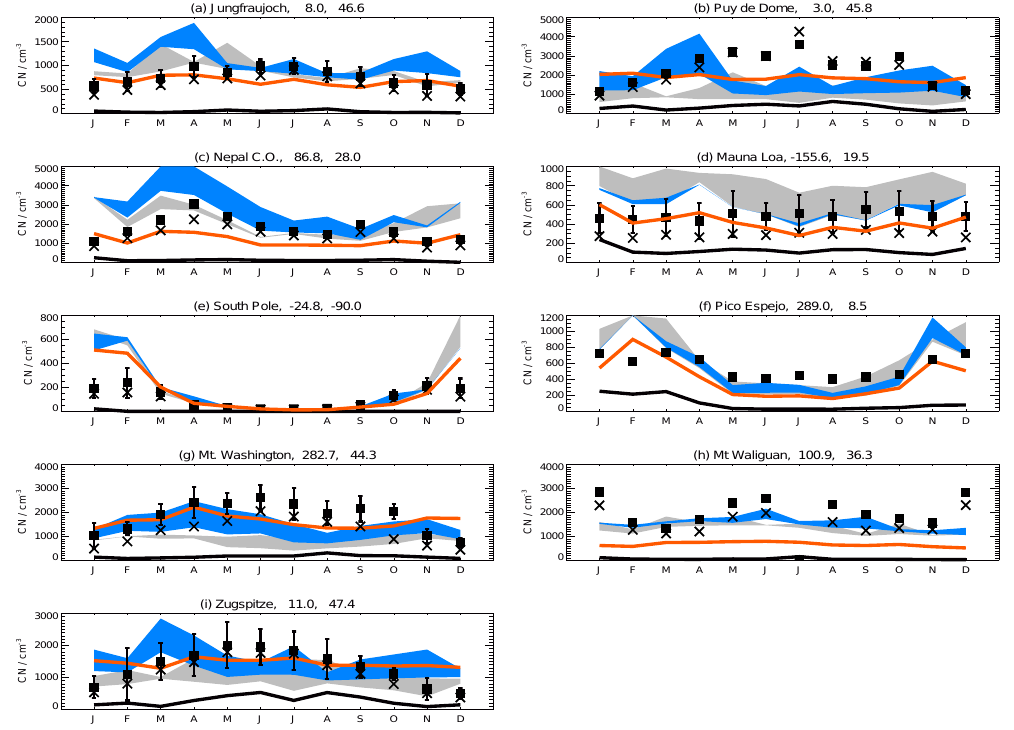
Fig. 4. Seasonal cycle of CN concentrations (at ambient temperature and pressure) at the FT sites shown in Table 2. Solid squares show observed monthly mean concentrations, crosses show observed monthly median concentrations and vertical bars show the standard deviation of the observed monthly mean (displayed only where there are 4 or more years of observations). The model experiments are described in Table 1: Black line shows the model with primary particulate emissions only (PRI), bottom of grey shading shows model with primary emissions and BHN (BHN), top of grey shading shows model with BHN and increased EC/OC number emission (PRICAR). Red line shows model with BHN and increased primary sulfate number emission (PRISUL). Blue shading shows model with primary emissions, BHN and activation BL particle formation, with the width of shading showing sensitivity to varying nucleation coefficients from A = 2 × 10 − 7 s − 1 (ACT1) to A = 2 × 10 − 5 s − 1